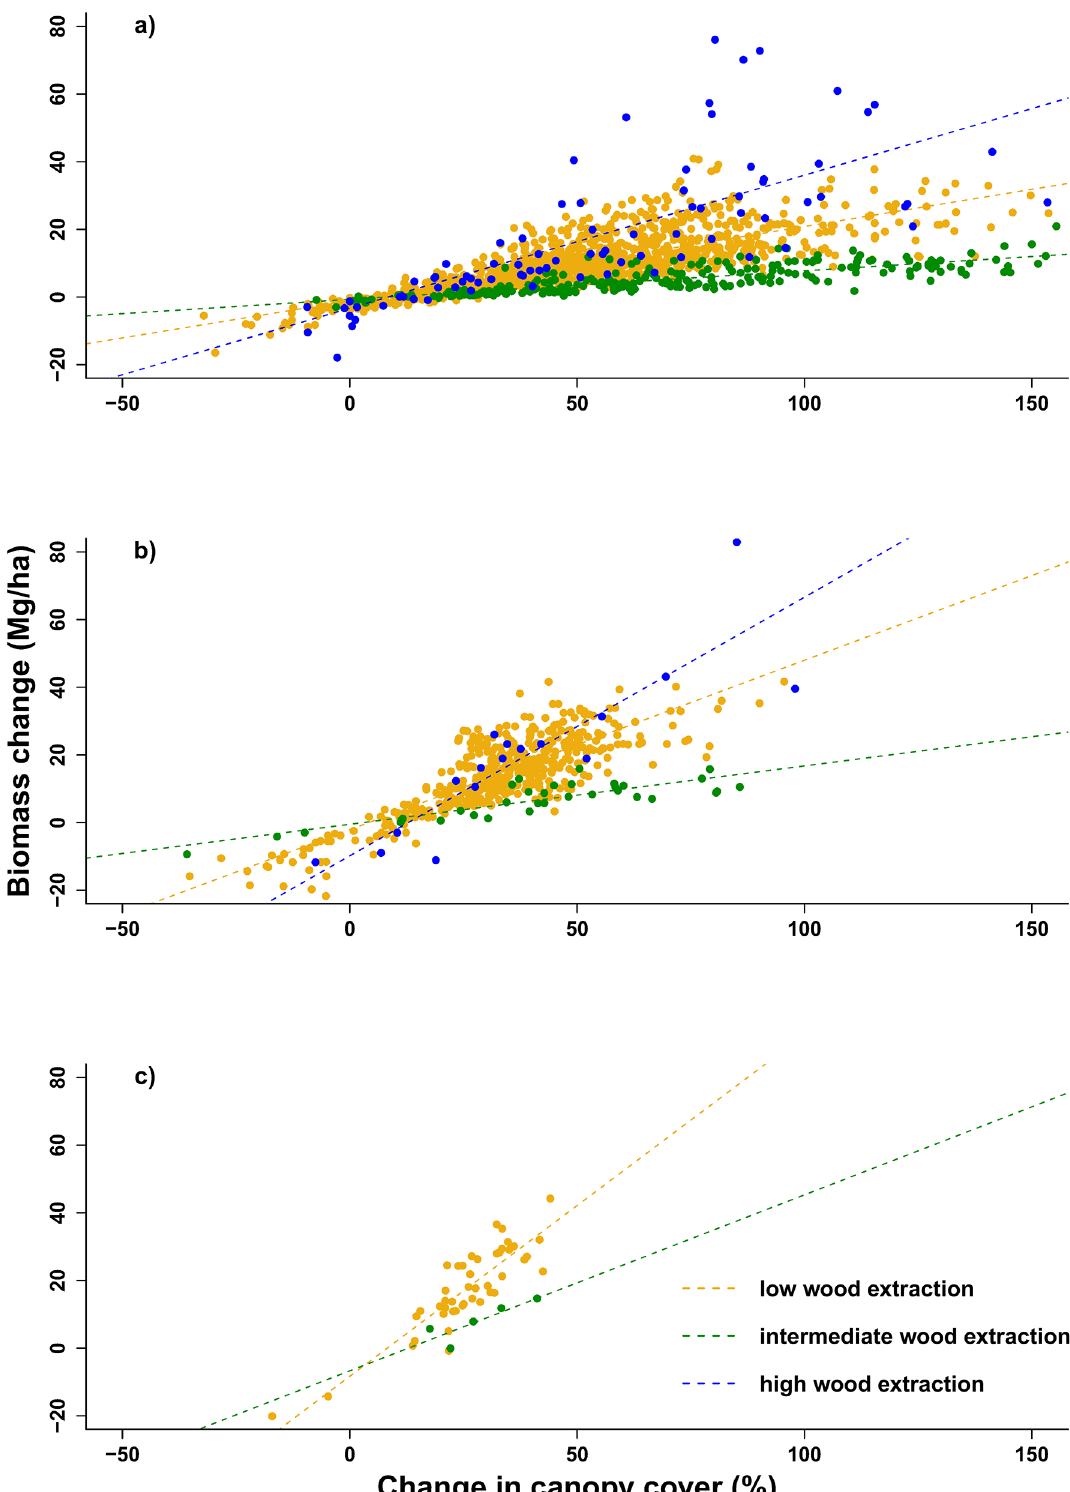
Fig 3. Height-specific biomass change as a function of relative change in canopy cover per grid cell. Height categories are a) 1 – 3 m, b) 3 – 5 m and c) 5 – 10 m for rangelands of high, intermediate and low wood extraction pressure. There were no data for the 5 – 10 m height class in the high wood extraction rangeland and the > 10 m height class for all rangelands as there were no grid cells with an average height over 10 m. Grid cell size: 25 m x 25 m.